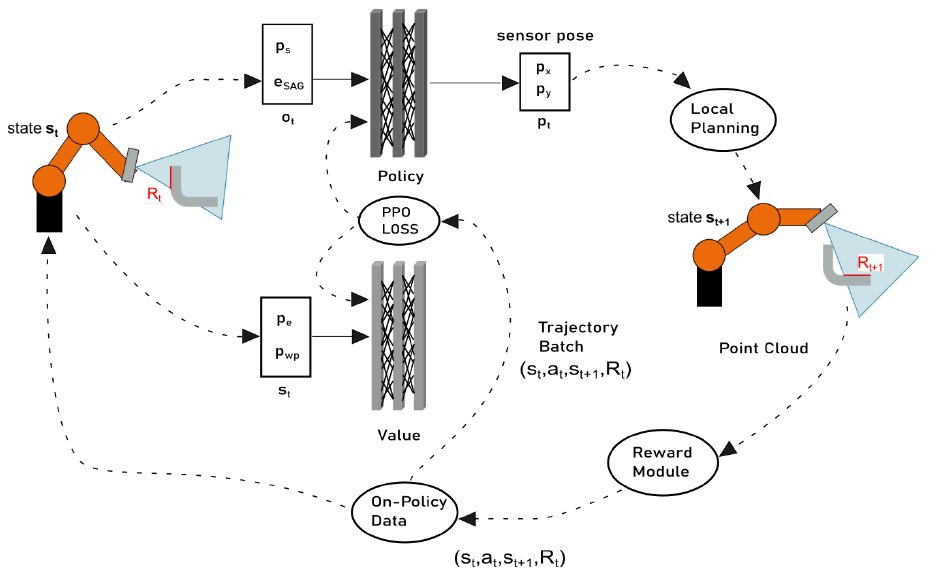
Figure 5. PPO approach for view planning. Here, e SAG represents the surface area gain, p s the sensor pose, p wp the current workpiece pose, p e the current robot pose and p t = ( p x , p y ) T the selected sensor